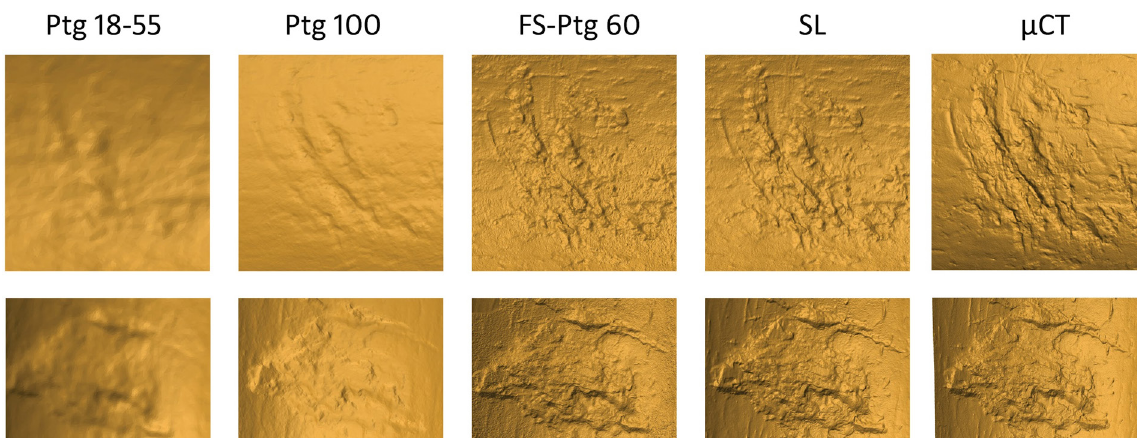
Fig. 6.7. Bone retoucher digitised with photogrammetry using a zoom lens (Ptg 18–55), a fixed focal macro lens (Ptg 100), focus stacking photogrammetry (FS-Ptg 60), structured light (SL) and microCT